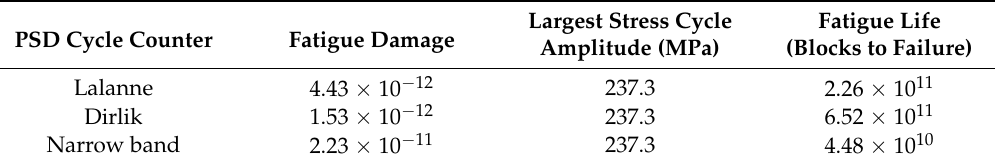
Table 9. Fatigue life using critical plane approach under residential road excitation.